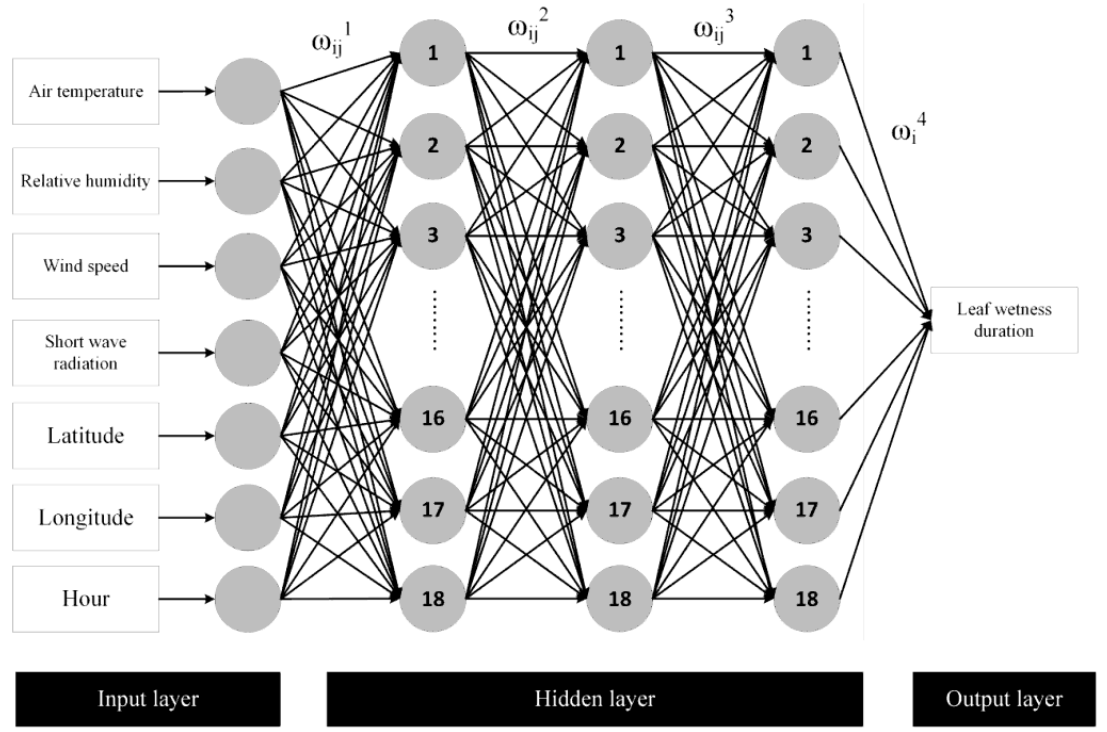
Figure 4. Structure of the deep neural network (DNN) model used in this study.